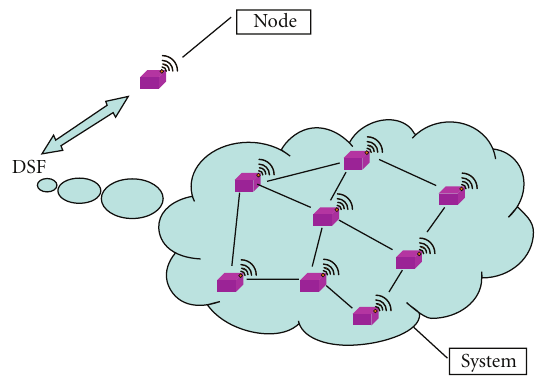
Figure 3: Data sharing mode.